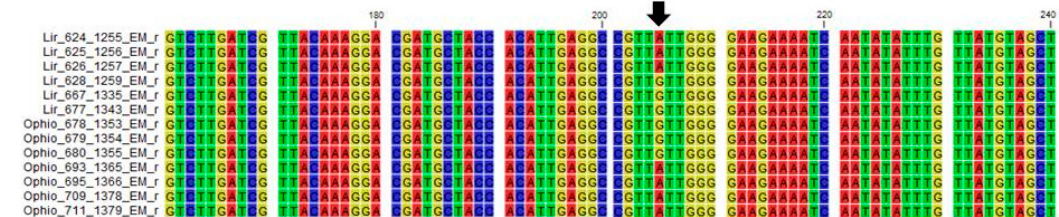
Figure 2. Fragment of a multiple alignment of the rbcL region from a selection of Liriope and Ophiopogon samples, highlighting a number of atypical samples. Liriope Samples 624, 625, and 626 match the consensus Liriope sequence. Ophiopogon Samples 678, 679, and 680 match the Ophiopogon consensus. Liriope Samples 628, 667, and 677 and Ophiopogon Samples 693, 695, 709, and 711 are atypical in the SNP position highlighted by the black arrow.